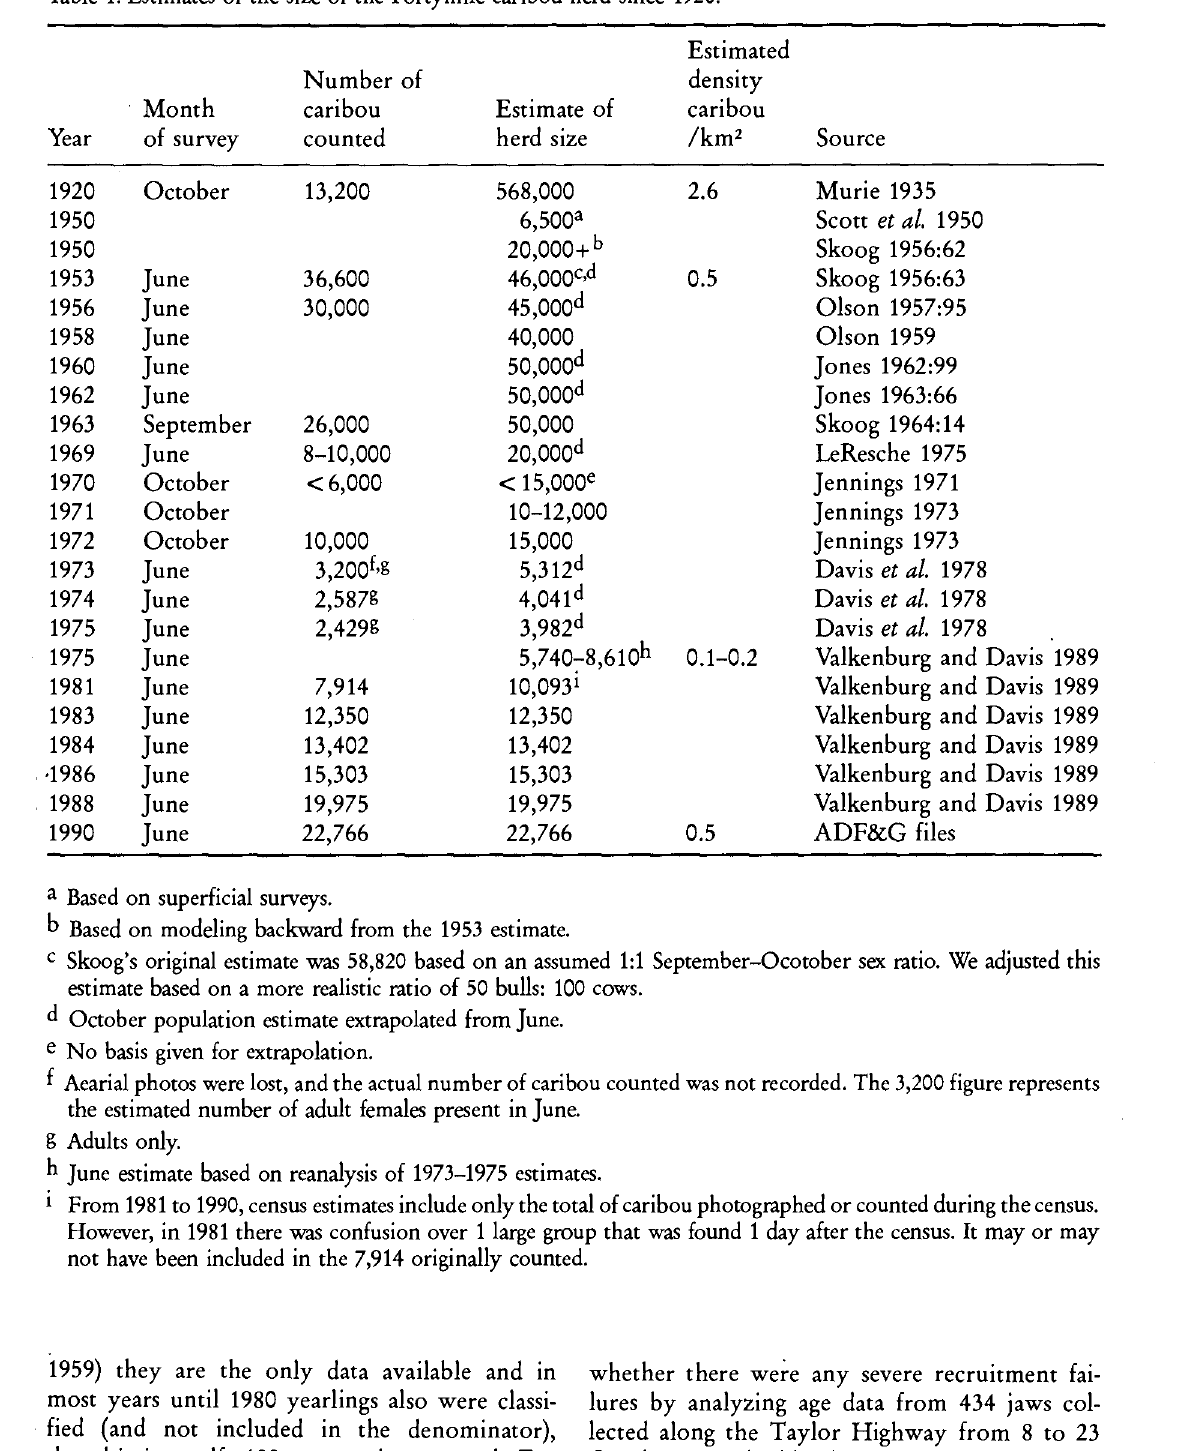
Table 1. Estimates of the size of the Fortymile caribou herd since